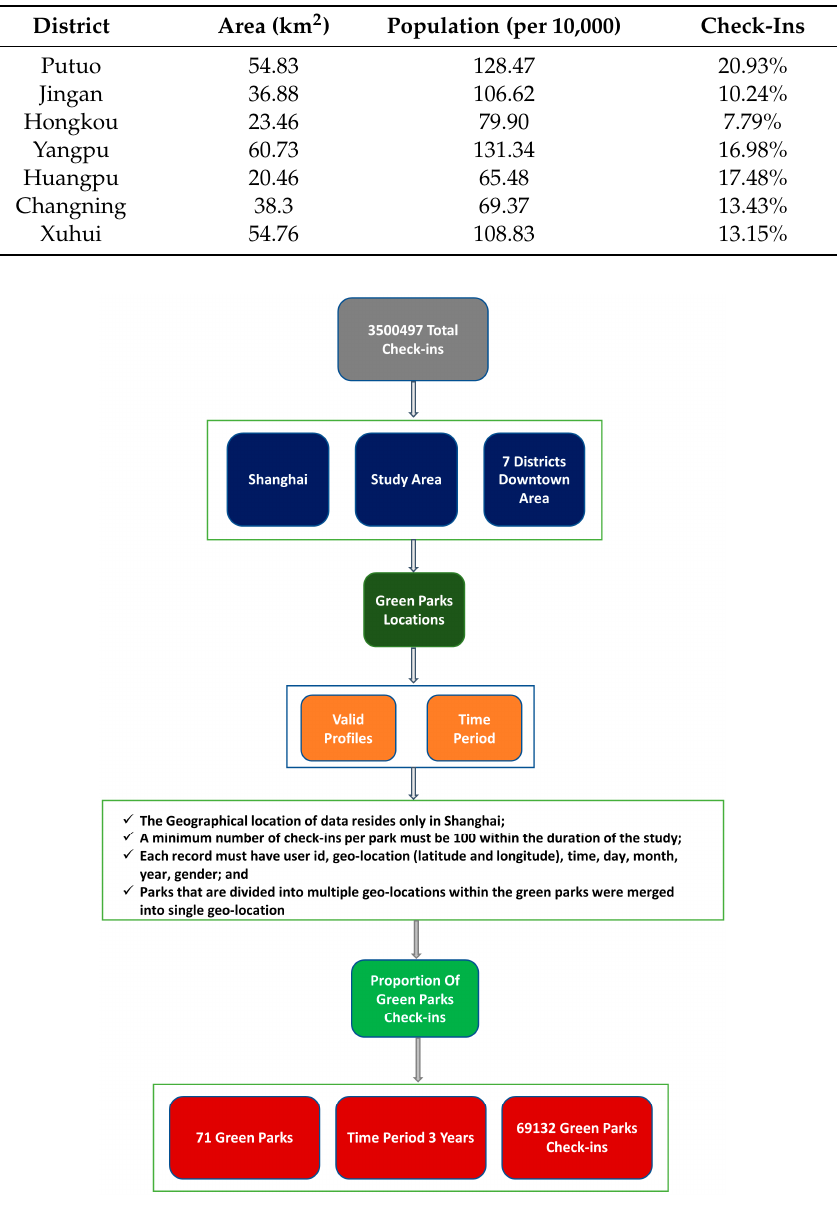
Figure 2. Criteria. Figure 2.